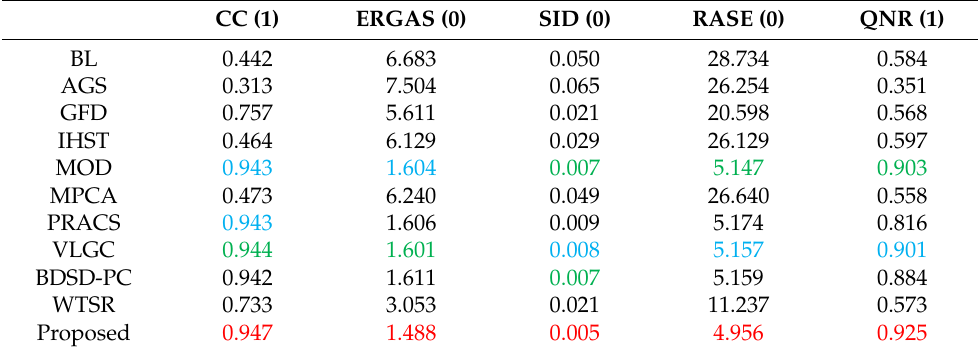
Table 4. The fourth group of quantitative